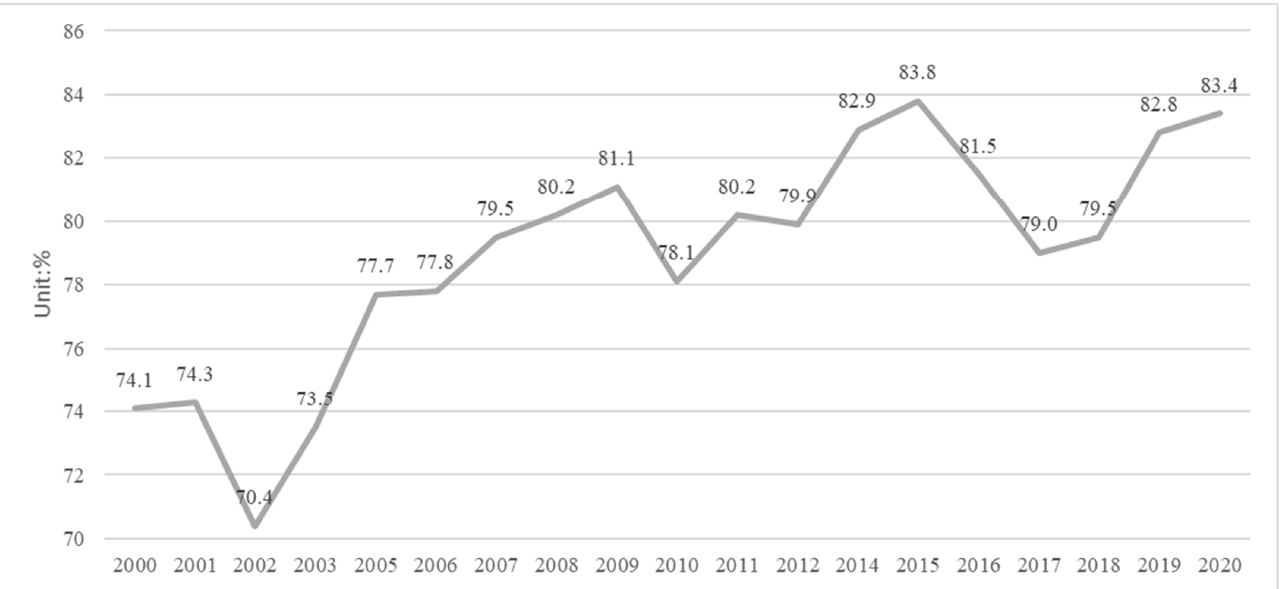
Figure 1. Liabilities of real estate development enterprises in Guizhou Province from 2002 to 2020.